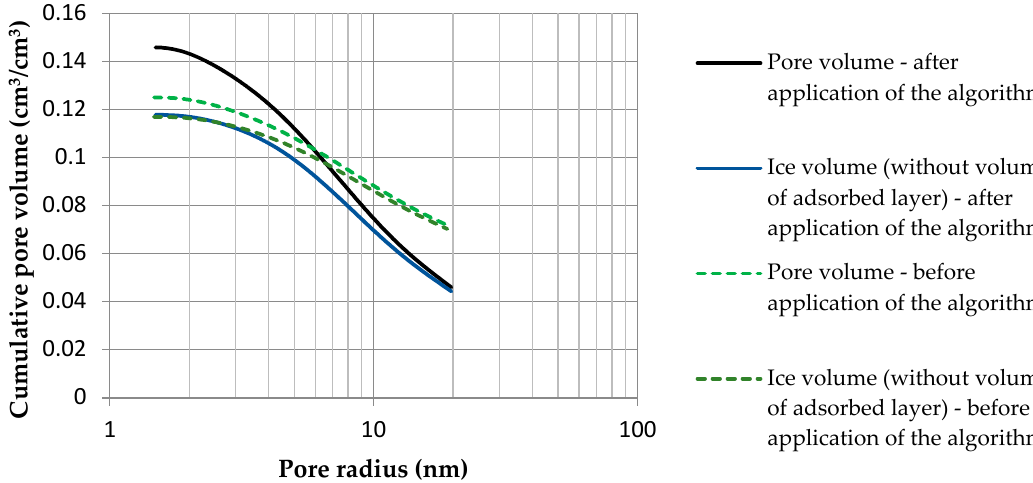
Figure 13. Pore size distribution that was obtained by thermoporometry from the phase transition energy distribution with the use of the modified algorithm.